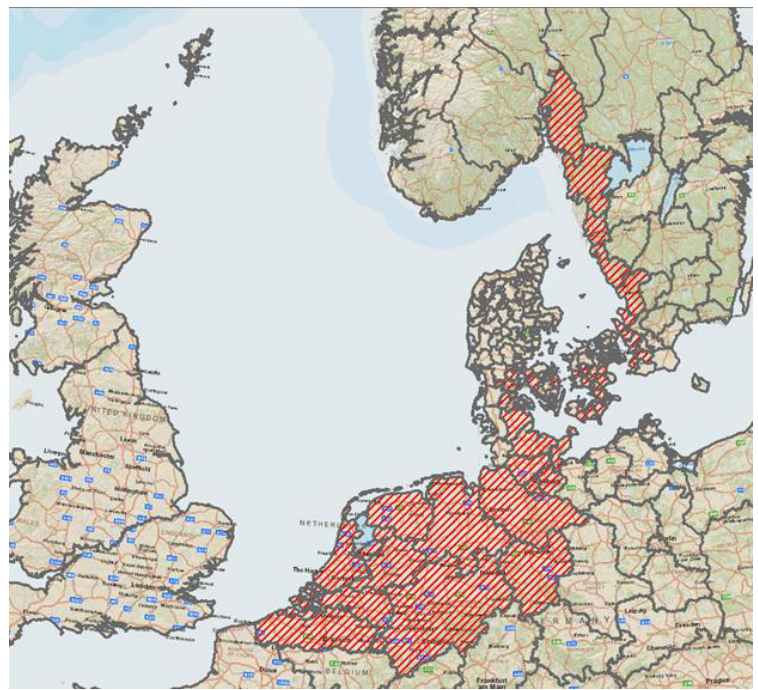
Figure 4. The GreCOR catchment